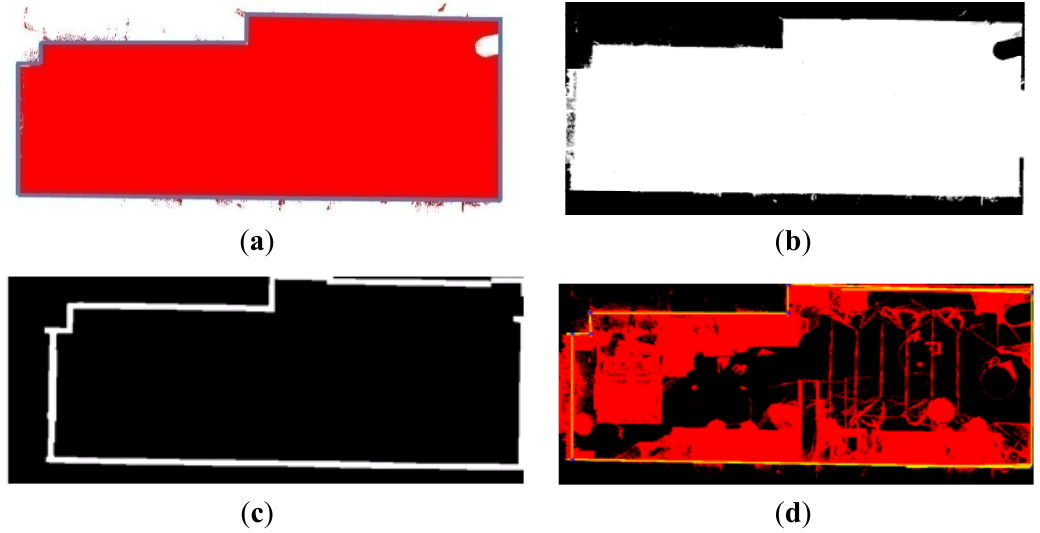
Figure 3. Stages in a wall segmentation process. ( a ) Visualization of the point cloud from a zenital viewpoint. ( b ) Binary image generated after discretization. ( c ) Boundary detection. ( d ) Defining edges and corners in the